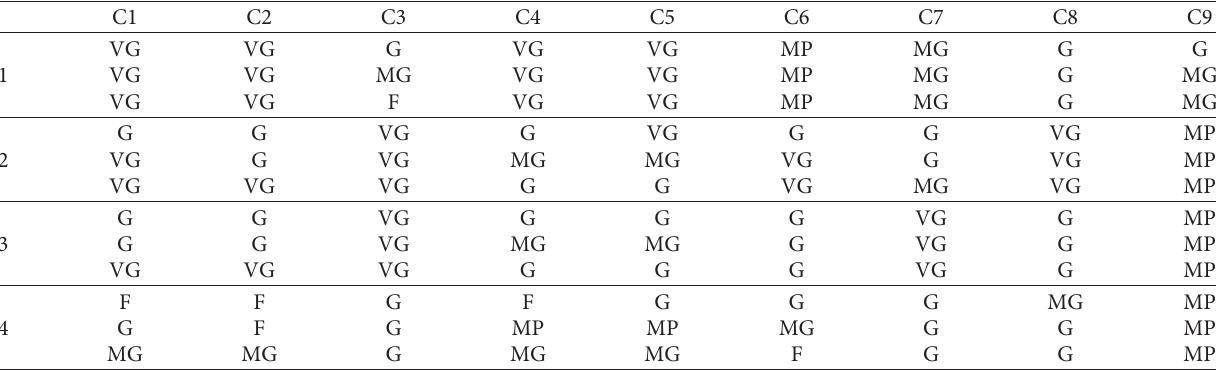
Table 10: 3 DMs’ evaluations of the hotel website and digital solutions provider firms with respect to each criterion.